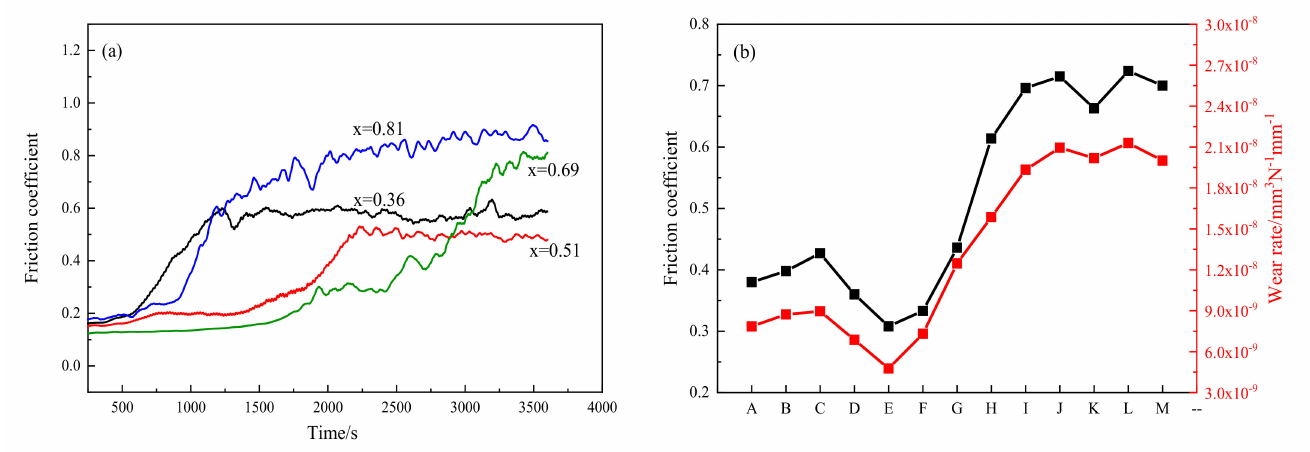
Figure 9. Room-temperature wear experiments on the (TiCrV)x-(TaW)1-x (A-M) binary system HEA films: ( a ) friction-coefficient curves of Samples B, E, H, K; ( b ) average friction coefficient (black line) and wear rate (red